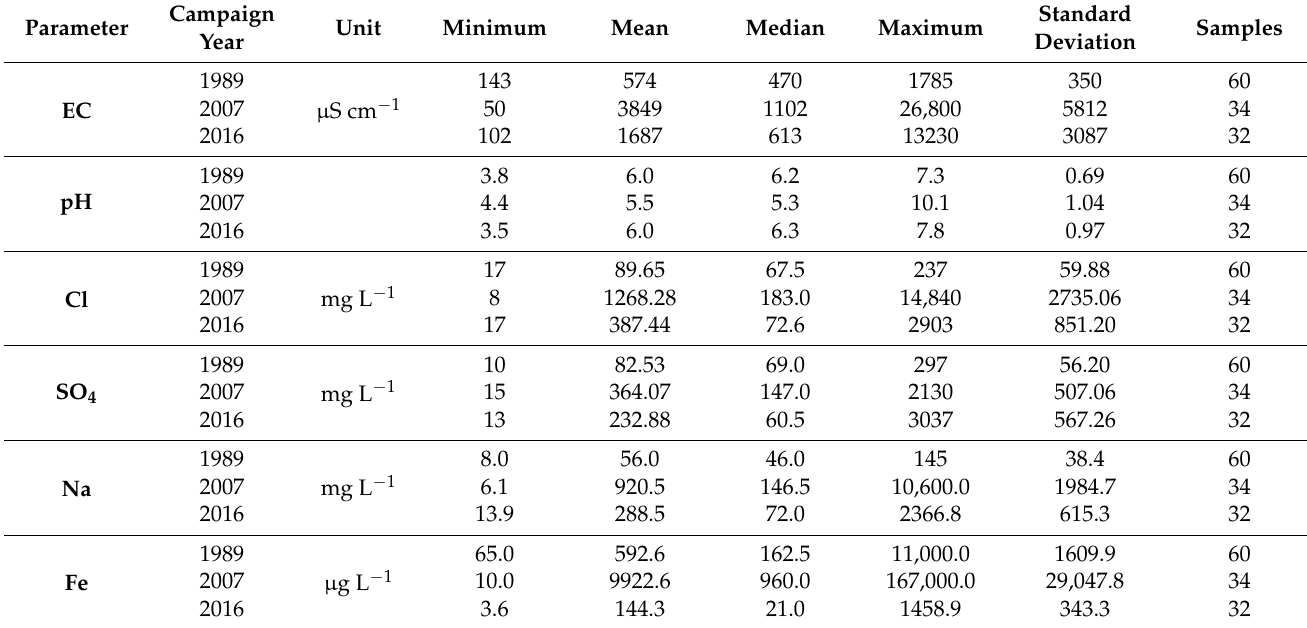
Table 2. For the selected periods (1989, 2007, and 2016), summary of statistics for analytical data and groundwater samples in the study